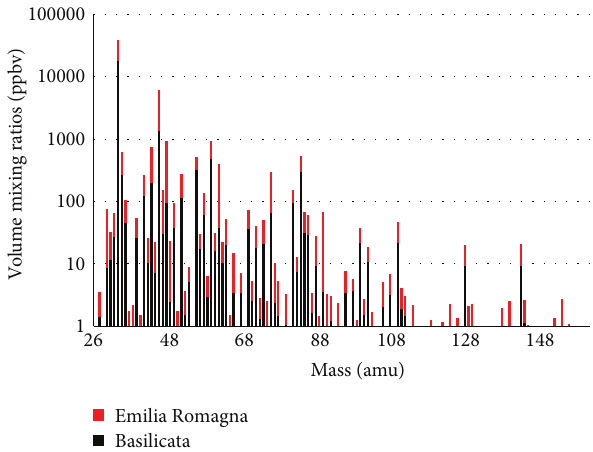
Figure 1: Mean VOC fingerprint of tomatoes originating from two regions measured by PTR-MS.